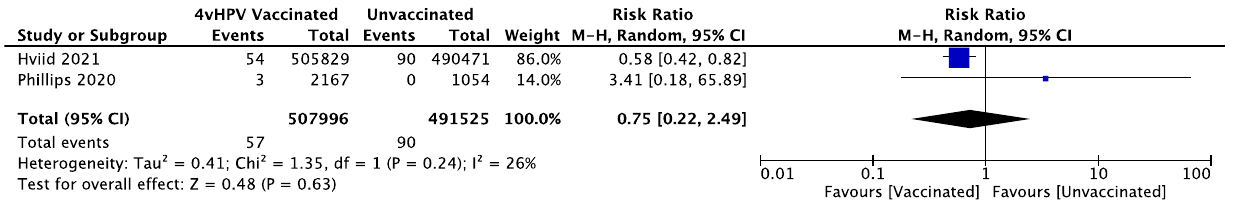
Figure 2. Risk of POI with 4vHPV vaccination relative to other or no vaccination [4,15 – 17]. Two studies evaluated the differences between HPV vaccination with 4vHPV and no vaccination; the incidence of POI did not differ between groups (RR 0.75 (95% CI 0.22 to 2.49) I 2 = 26%) (Figure 3).